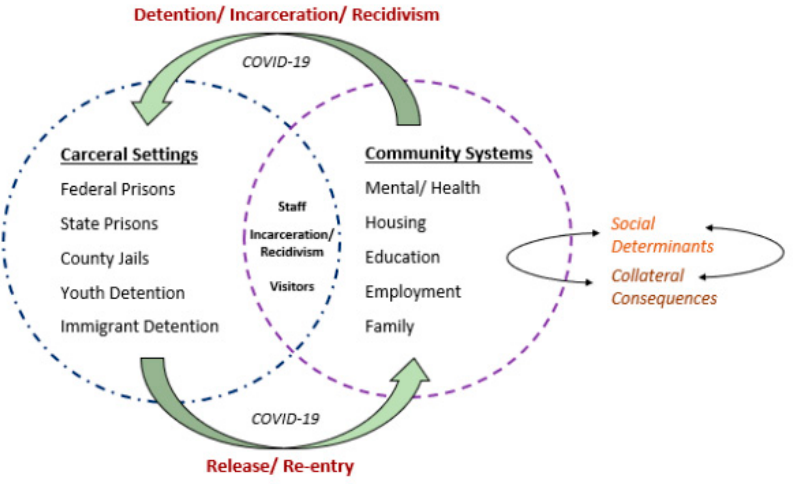
Figure 4. The important role of social determinants in public health disparities highlighted in Intersection #2: COVID-19 and US incarceration.